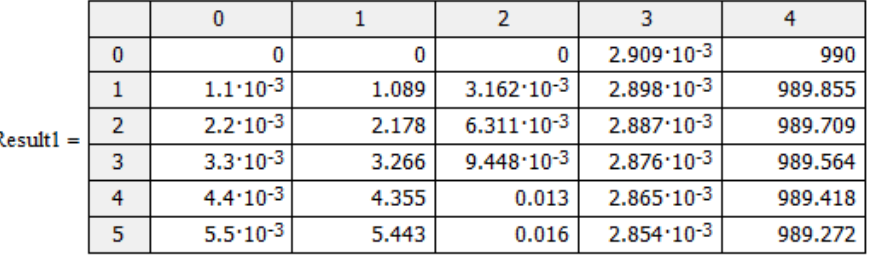
Figure 3 – An example of data for a numerical solution of ODEs (1) Рис . 3 – Пример матрицы численного решения системы ОДУ